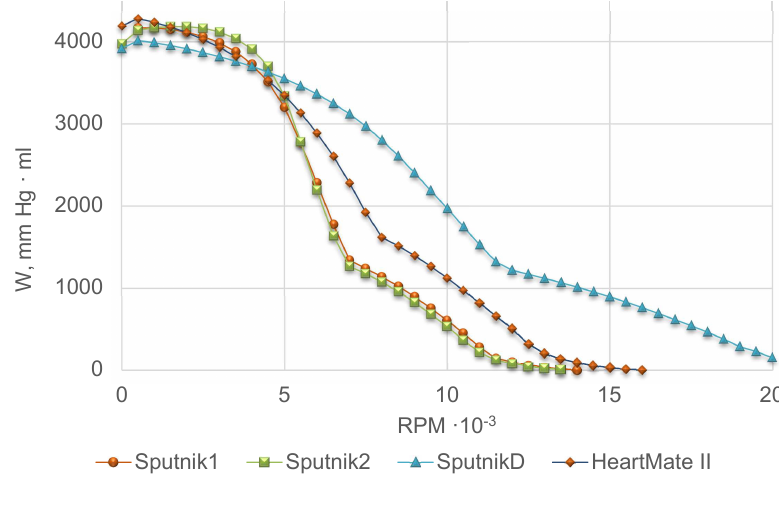
Figure 7. The work of the